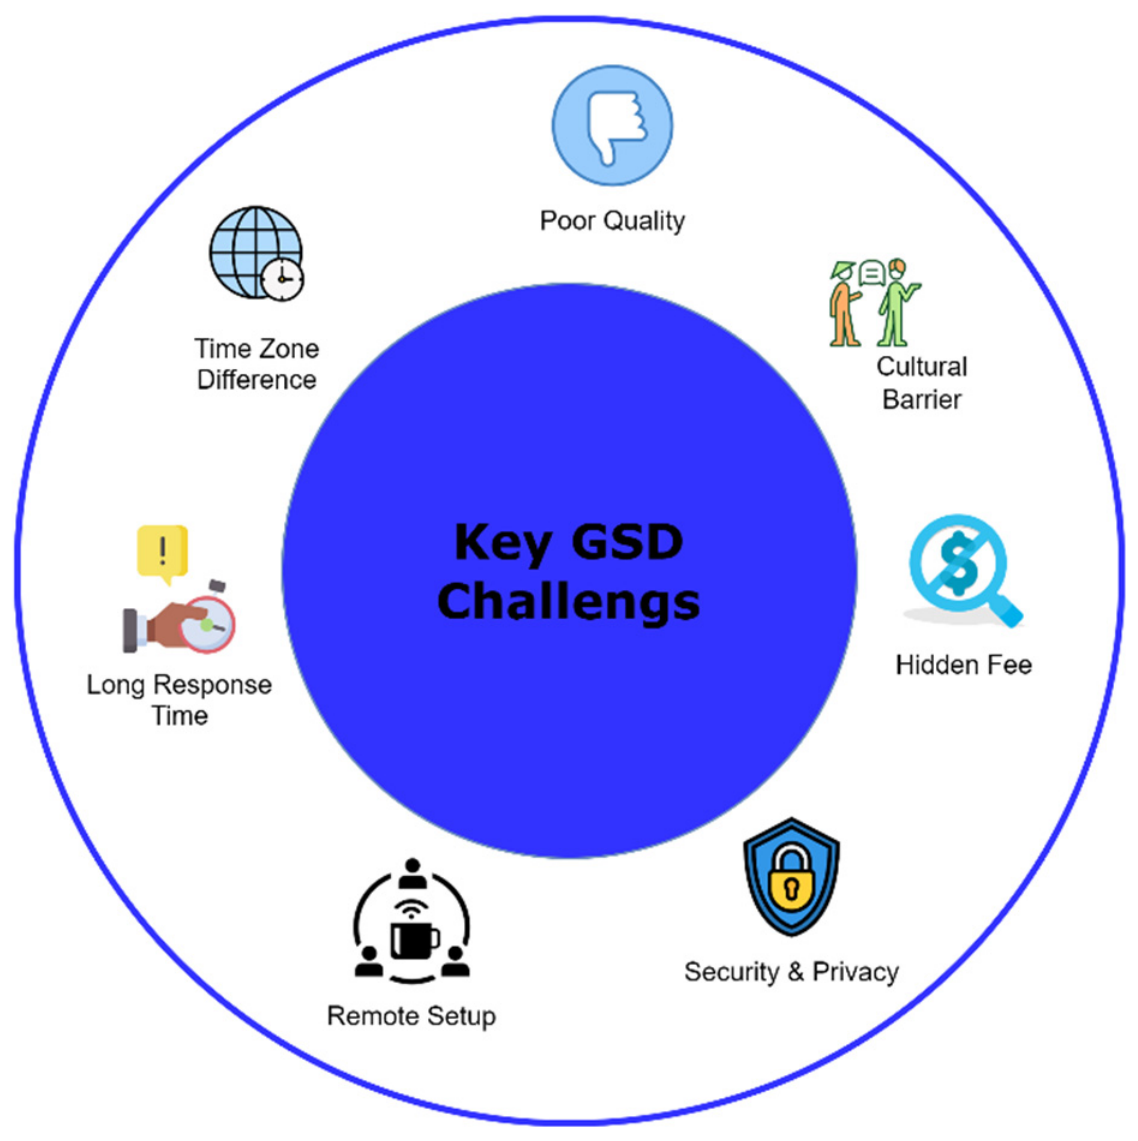
Figure 1. Key difficulties faced in GSD.